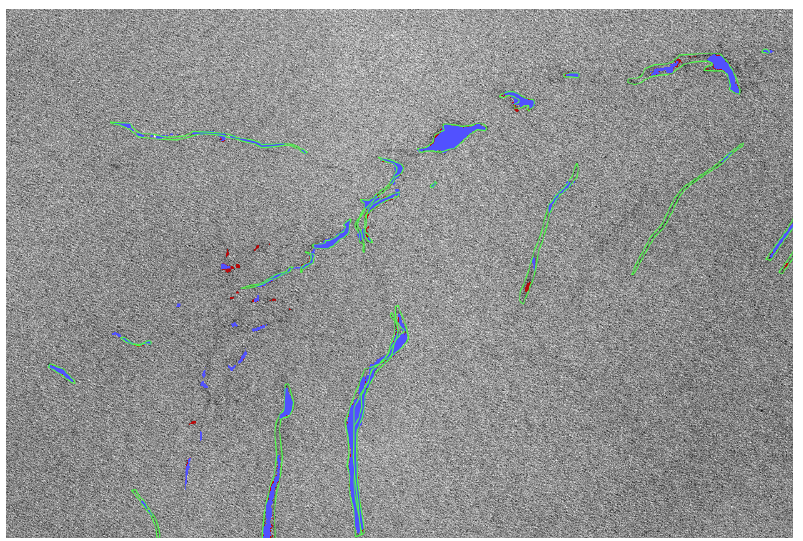
Figure 18. An example of the baseline SAR-based enhanced FC-DenseNet (red) and the early fusion version (blue) predictions to be compared with the green polygons representing the photo- interpretation slick